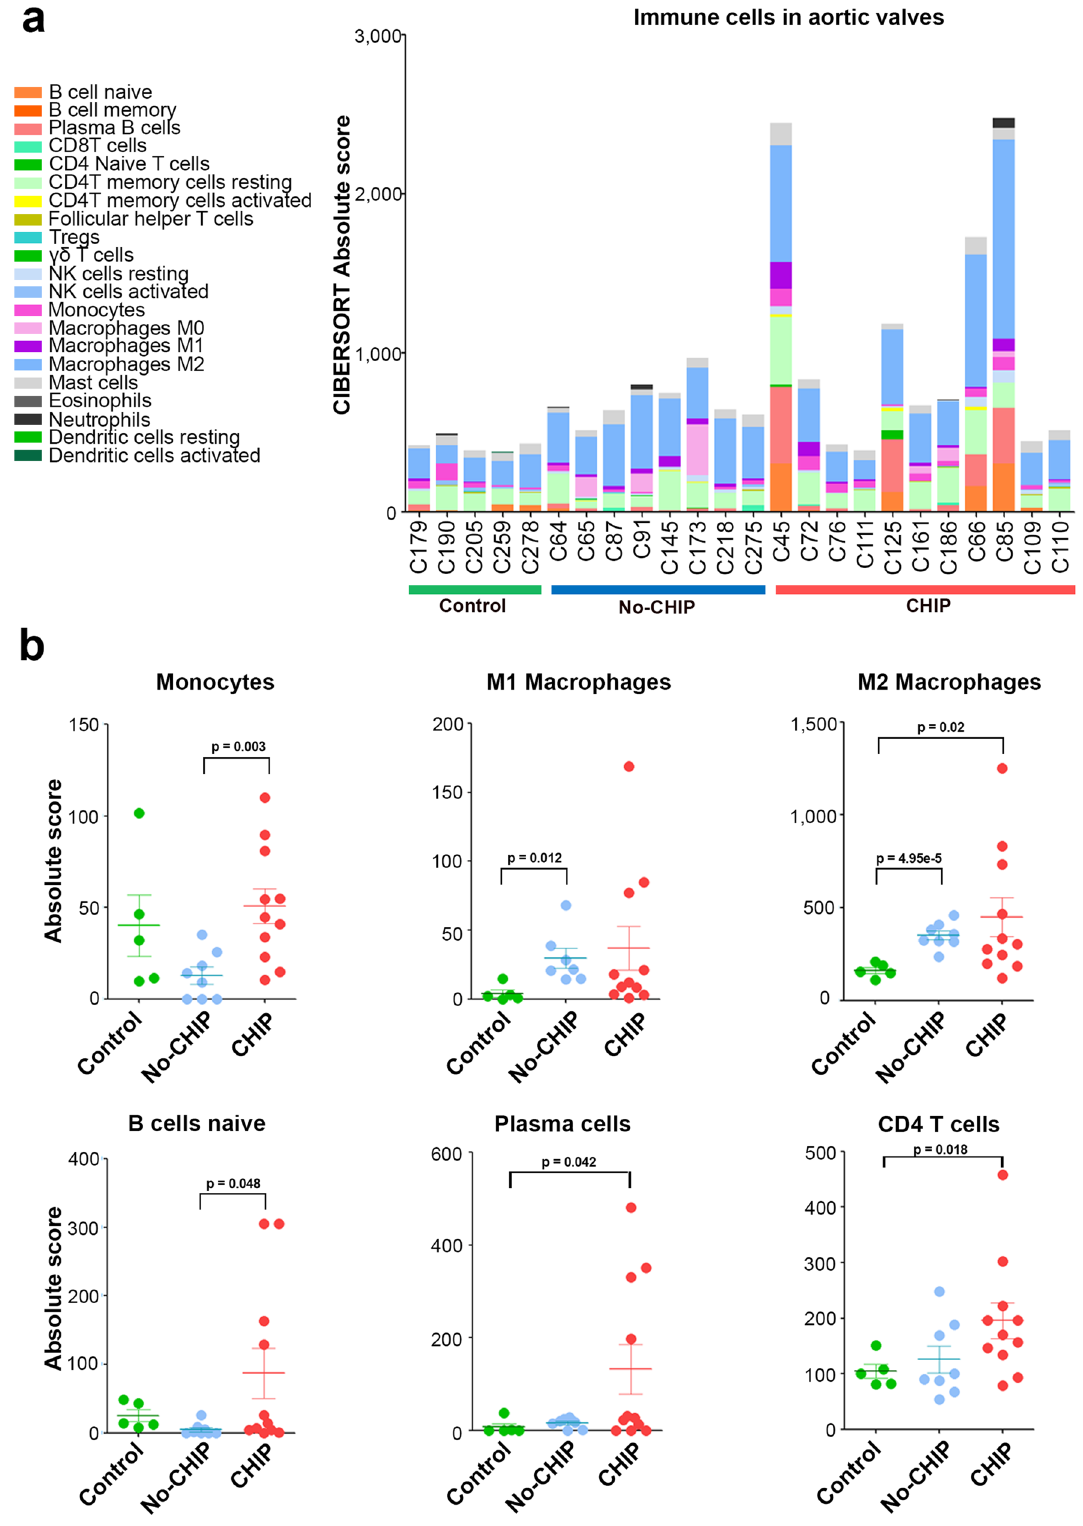
Figure 4. Immune cell profiles in the aortic valves. ( a ) Content of immune cells profile in aortic valve samples obtained by RNA-Seq data. ( b ) Quantification of different immune cell subsets in control, No-CHIP, or CHIP samples. CD4 T cells include memory and naïve T cells. Mean with SEM, are shown. p values are referred to T-test comparisons between different